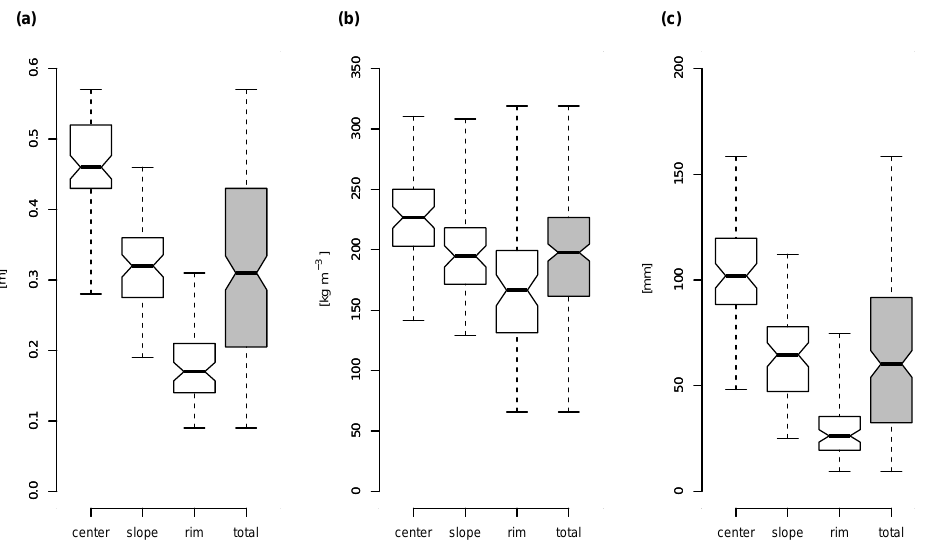
Fig. 6. Box plot of snow depth (a) , snow density (b) , and snow water equivalent (c) , measured on the microtopographic relief of polygon centres, slopes, and rims from 25 April to 2 May 2008, and averaged across Samoylov Island. The box plot shows medians and standard deviations for 216 plots (8 polygons with 9 sites on each of their centrers, slopes, and rims, i.e., 72 centres, 72 rims and 72 slopes). Table 5. Dates and durations of snow covered periods for the years 1998–2011. The snow height sensor was moved in 2002 (from polygon rim to polygon centre). Note that the snow season overlaps two calendar years. The length of snow season shown for 1999, for example, actually includes days from October 1998 through to May 1999. The total number of days shown in any one “year” is, therefore,